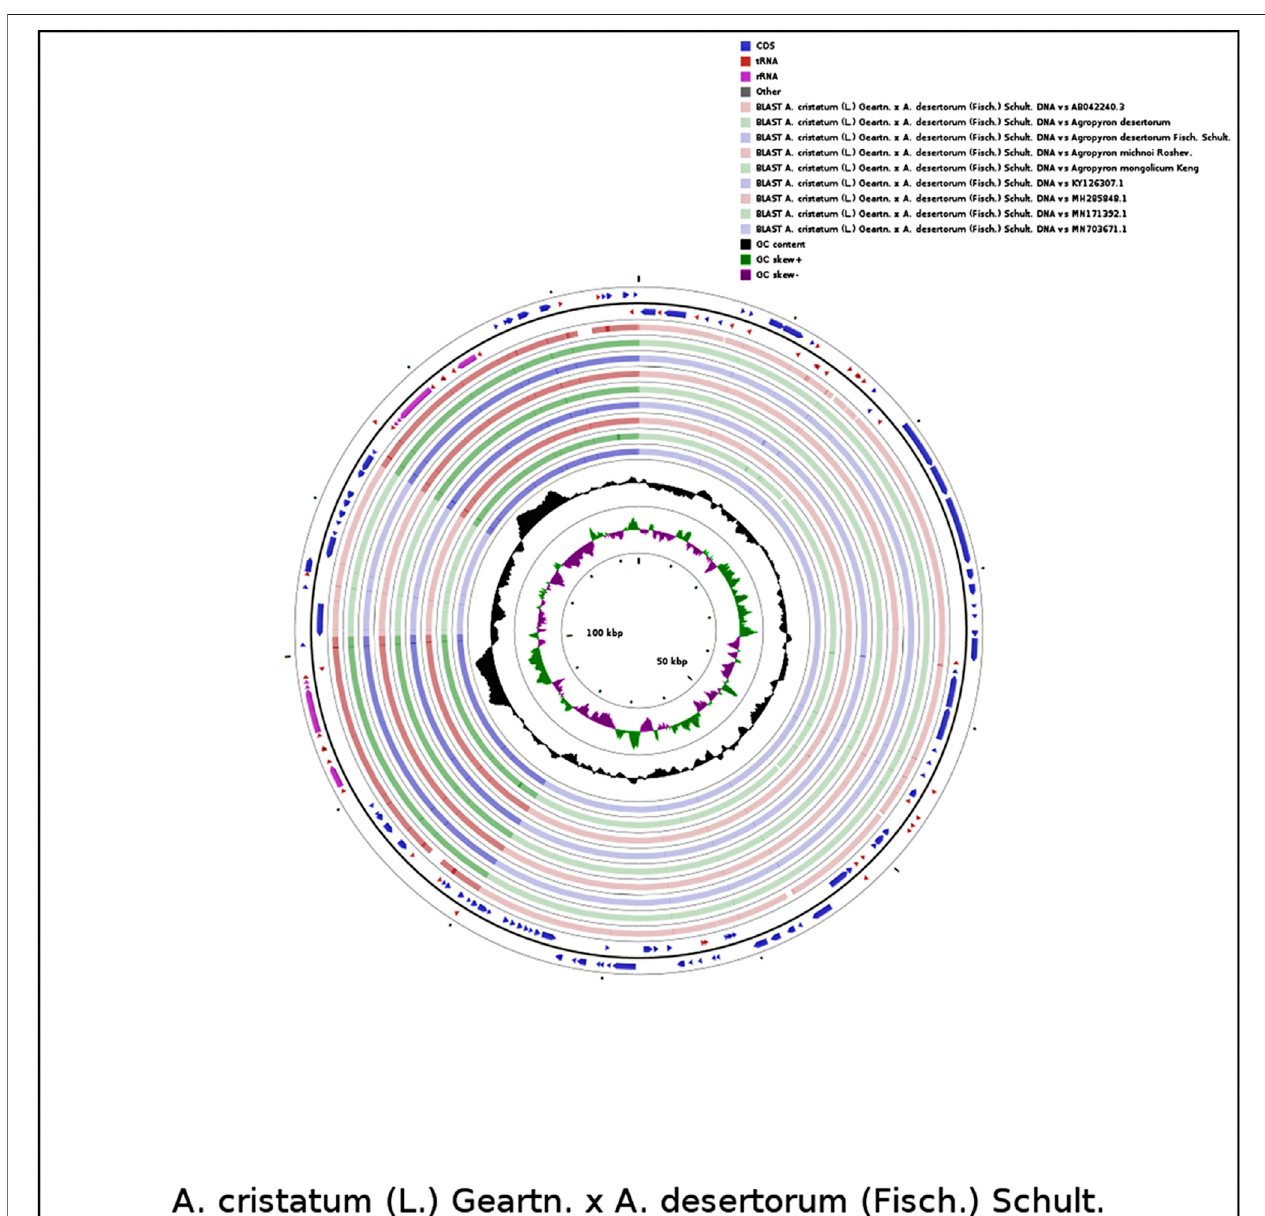
FIGURE7| Comparativeanalysisofchloroplastgenomestructures.Thetwooutermostcirclesdescribethelengthanddirectionofgenesinthegenome;thecircles inside represent similar results compared with other reference genomes; the black circles represent the GC content.